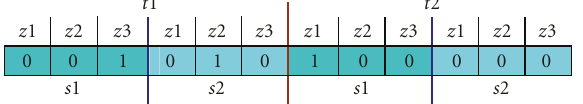
Figure 1: Example of a chromosome for the sensor deployment problem.